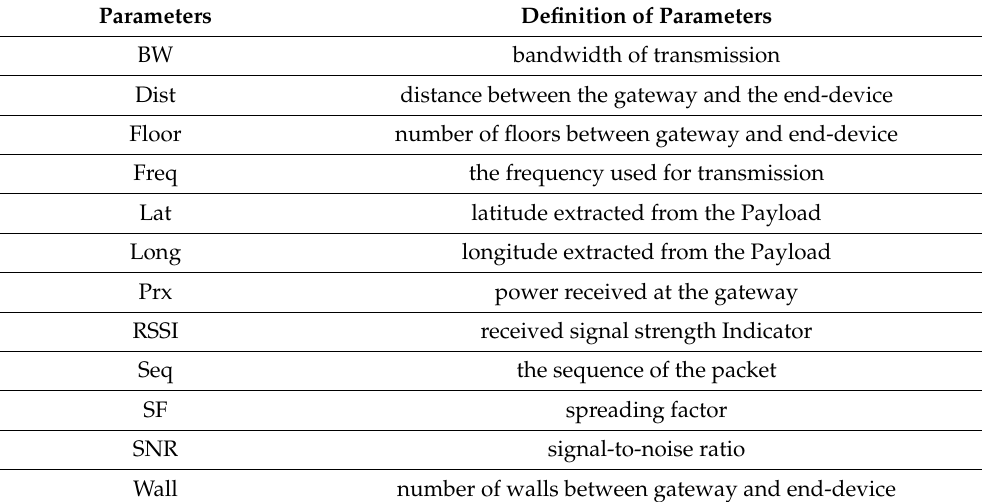
Table 6. Definition of